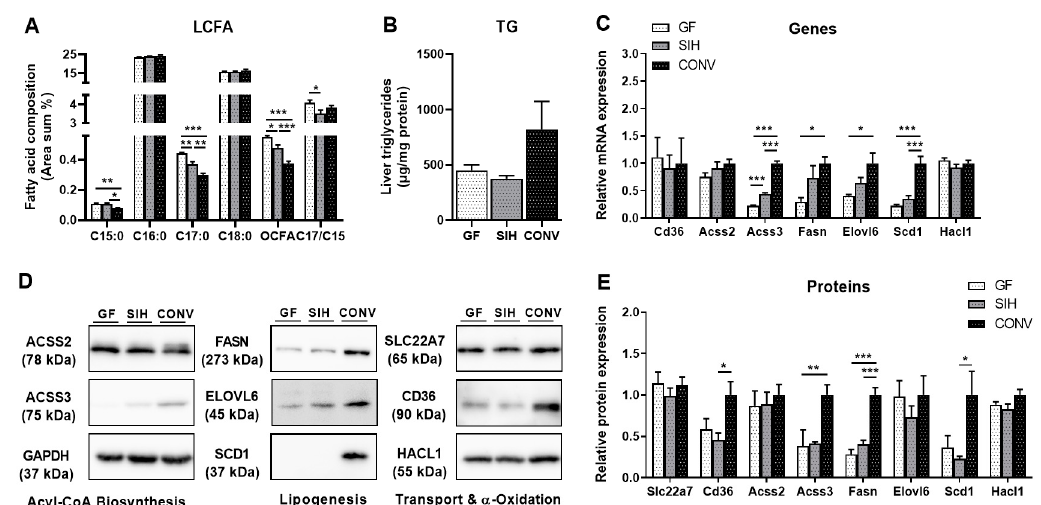
Figure 1. Germ-free mice (GF) and SIHUMI mice (SIH) on CHOW diet display a reduced hepatic de novo fatty acid synthesis, but increased relative OCFA compared to conventional mice (CONV). Twenty-week-old male C3H/HeOuJ mice on CHOW diet (Altromin fortified 1314): ( A ) long-chain fatty acid (LCFA) composition of hepatic phospholipid fraction. Results are expressed as area percentage of individual fatty acids to total area of detected fatty acids. ( B ) Hepatic triglyceride (TG) concentration. Analysis of fatty acid metabolism with both ( C ) mRNA and ( E ) protein expression. ( D ) Representative Western blots for fatty acid signaling. Data are mean + SEM ( n = 6) and expression data were normalized to CONV group. Hprt was used as the housekeeping gene and GAPDH as the loading control for the protein. * p < 0.05; ** p < 0.01; *** p < 0.001.